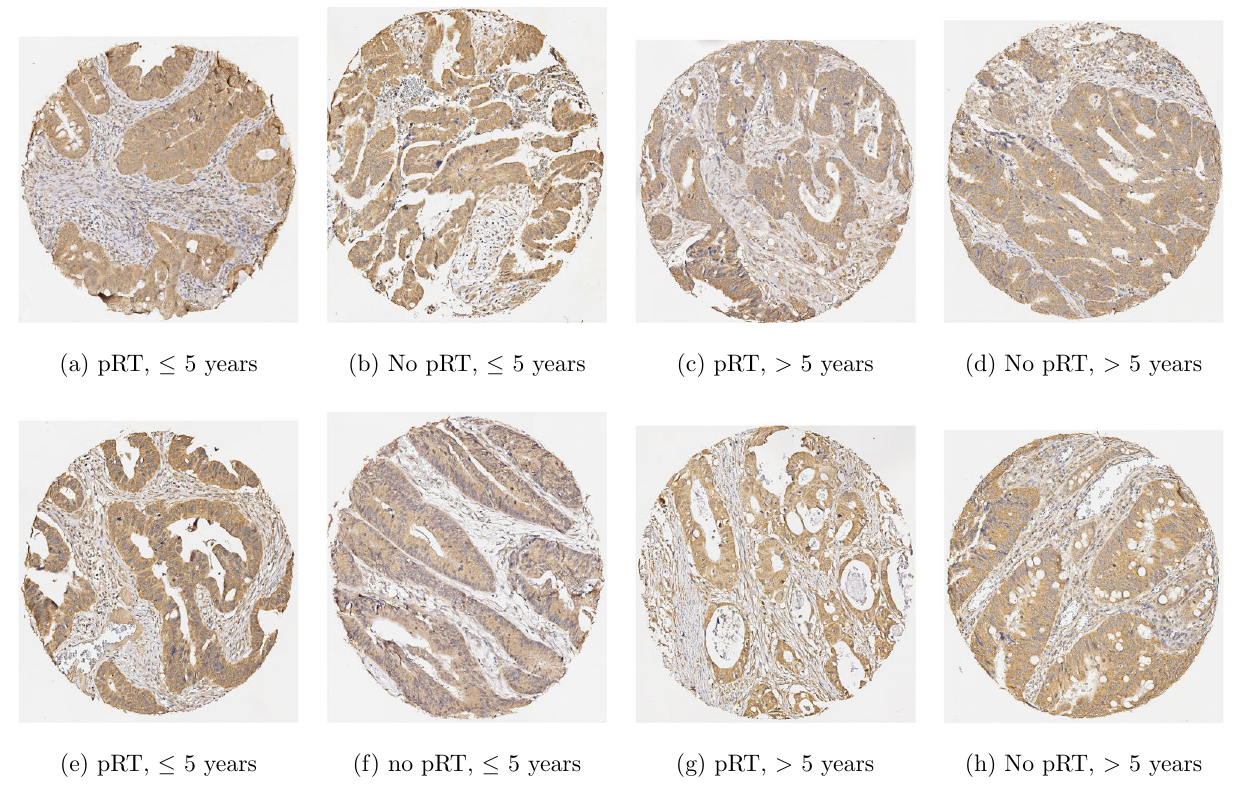
Figure 3. IHC stained tissue images of rectal cancer: ( a ) biopsy, and ( b )